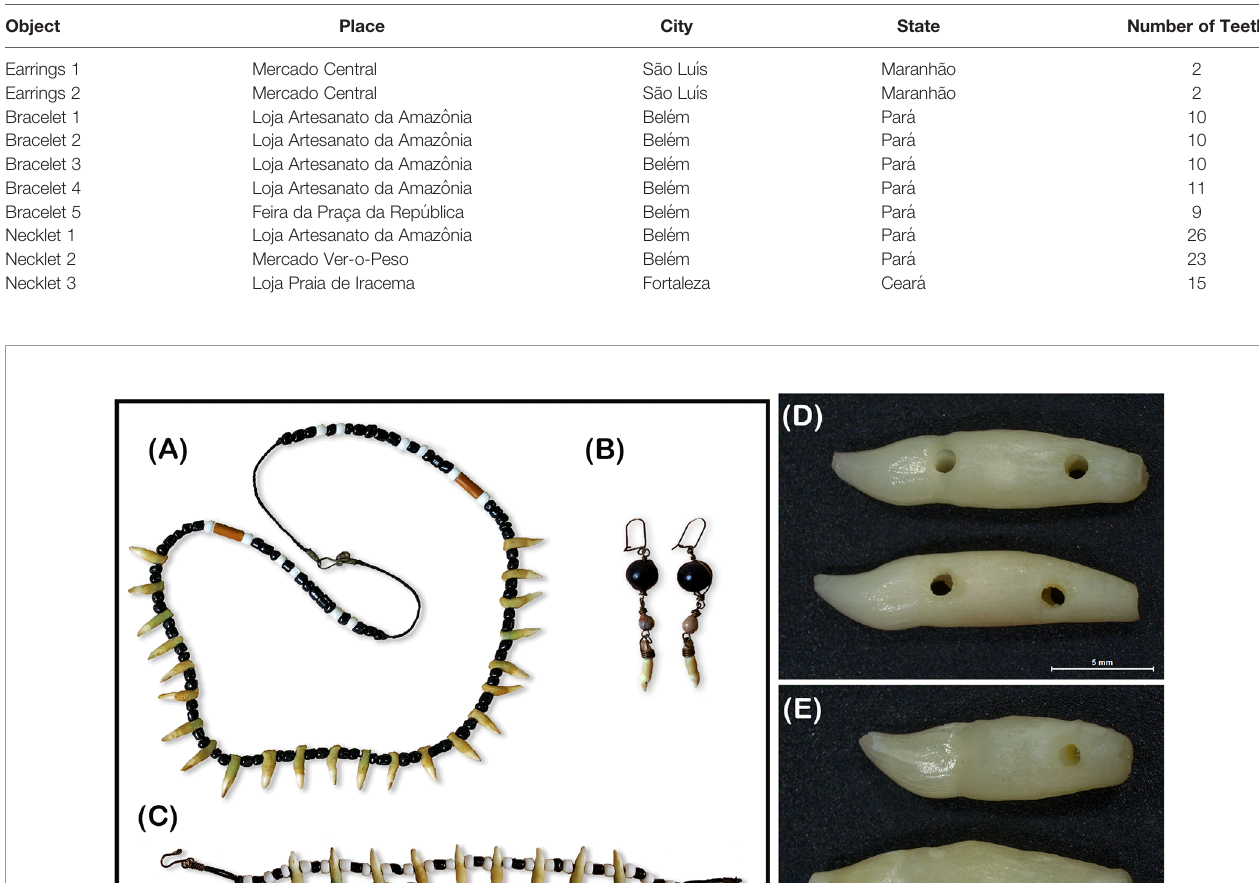
( Figure 1B ) were measured and used for further comparisons as two different control groups (see statistical analyses section).